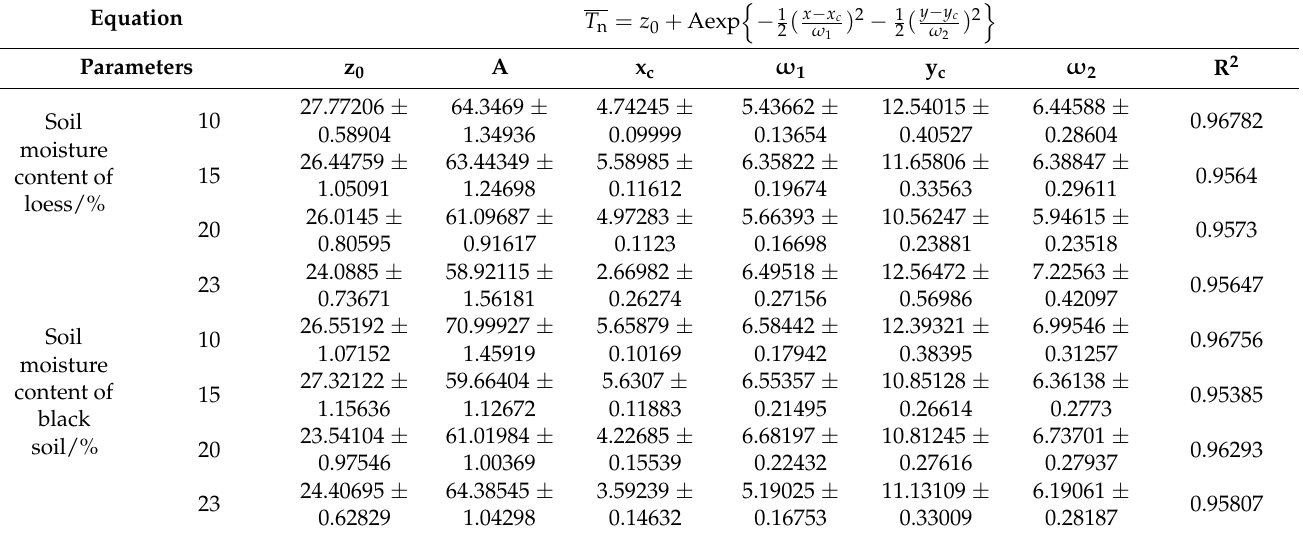
Table 4. The extreme points in the surface equation of the change in the internal temperature of the soil layer with irradiation time and soil depth.